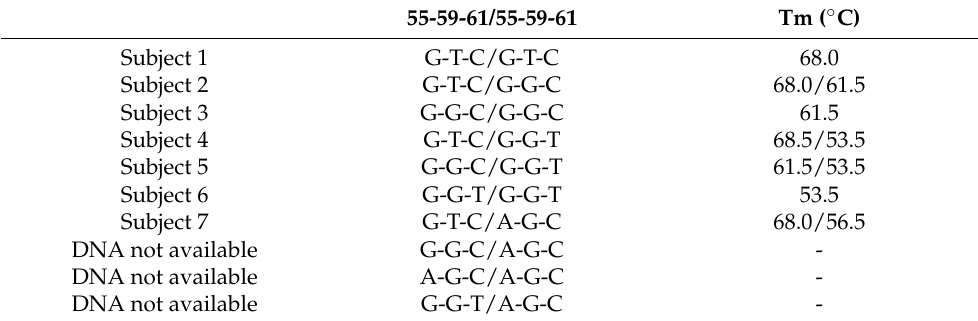
Table 2. Haplotype combinations of 55-59-61 and observed Tm values of probe-based FMCA analysis for 59T>G.